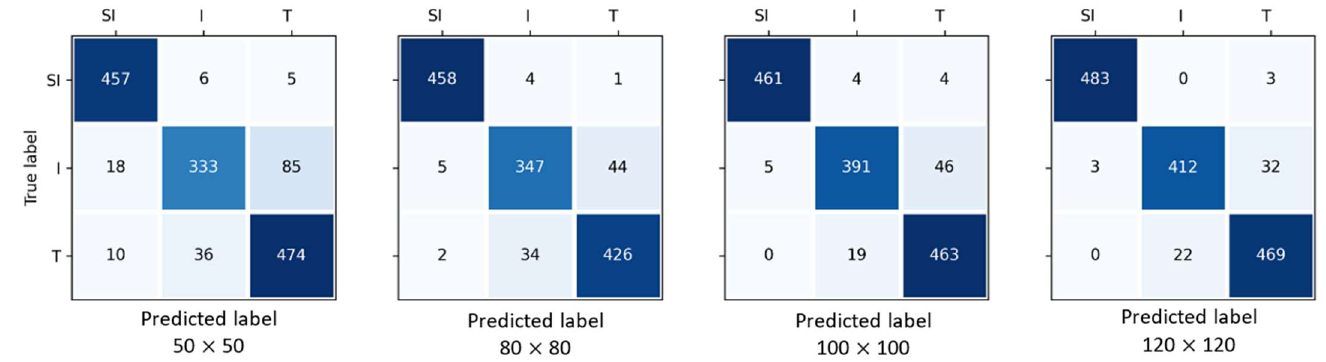
Figure 11. Confusion matrix for every resolution under validation.